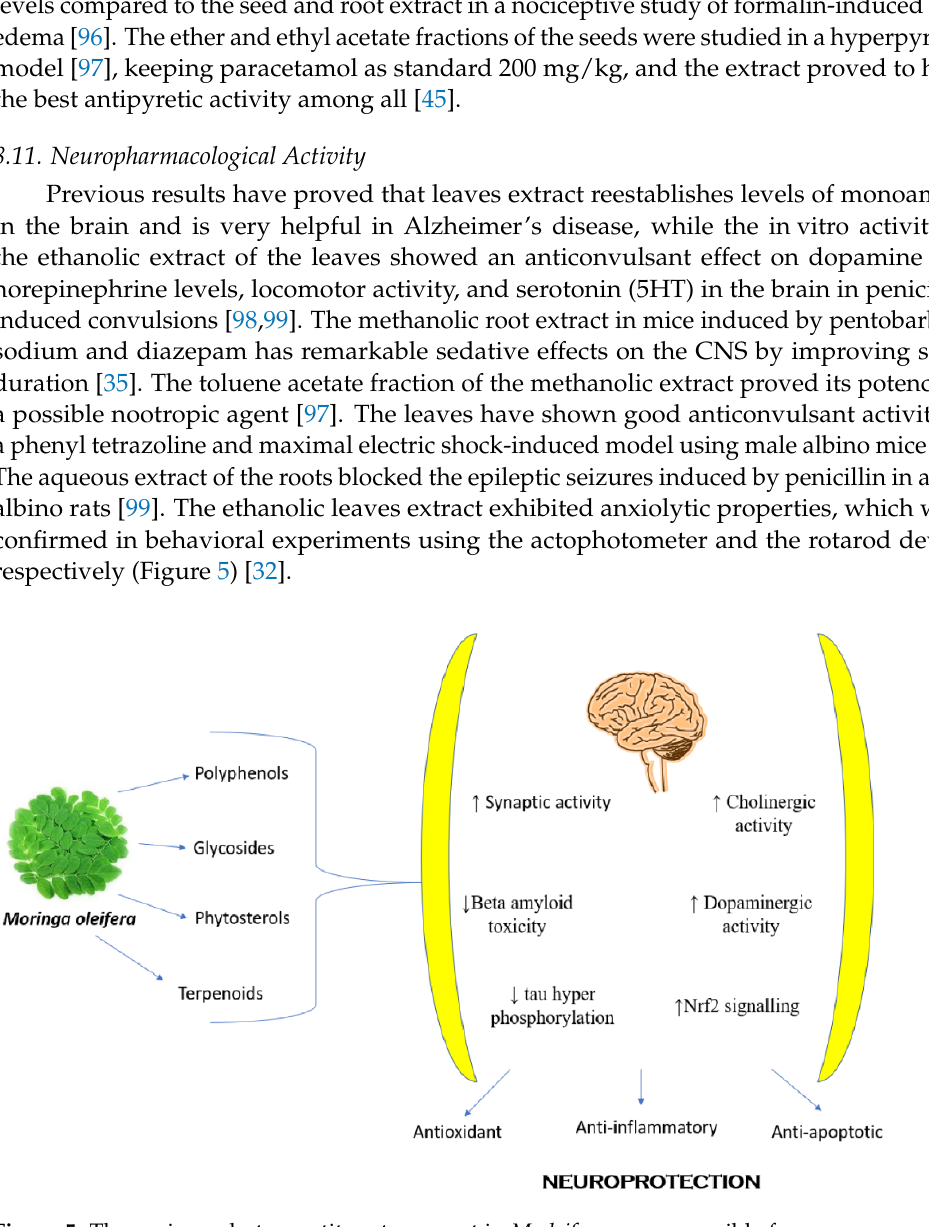
Figure 5. The various phytoconstituents present in M oleifera are responsible for numerous neuro- protective effects. M. oleifera is responsible for upregulating synaptic activity, cholinergic activity, dopaminergic activity, signaling of NrF2 (Nuclear factor erythroid 2-related factor 2), and simultane- ously decreasing beta-amyloid toxicity and phosphorylation of tau proteins.